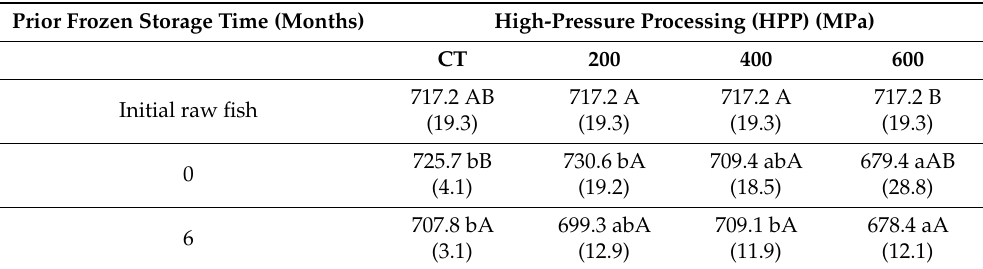
Table 6. Moisture content (g · kg − 1 muscle) * of initial raw fish and canned mackerel subjected to di ff erent processing conditions